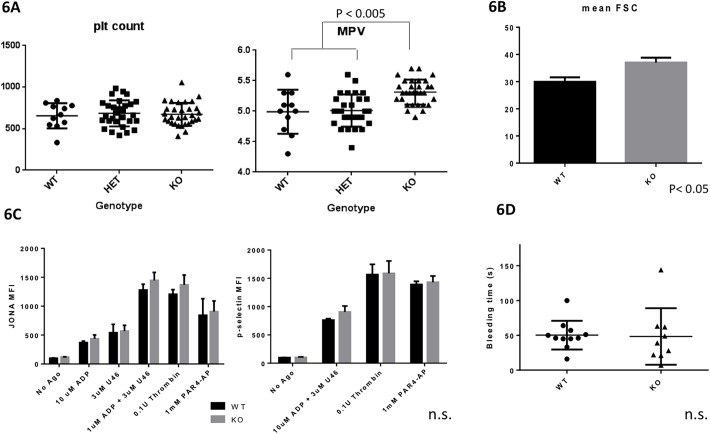
Arhgef3 KO mice have enlarged platelets, and normal platelet activation.(A) Peripheral blood was taken from 4 week old littermate mice with the indicated genotypes. Arhgef3 KO mice have significantly larger platelets (MPV) but normal platelet counts. (B) Mean forward side scatter (FSC) of platelets (gated as CD41/CD61+ from whole blood) confirmed that KO mice have larger platelets. (C) Flow cytometry for Integrin α2bβ3 conformational change (JONA MFI) and P-selectin exposure of platelets from littermate mice in response to ADP, thromboxane (U46), thrombin and PAR4-AP stimulation. There are no significant differences between WT and Arhgef3 KO platelets with any of the agonists tested. (3 independent experiments, n = 4/genotype). (D) Tail bleeding times of WT and Arhgef3 KO littermates showed no differences in bleeding time. (WT n = 10, KO n = 9).